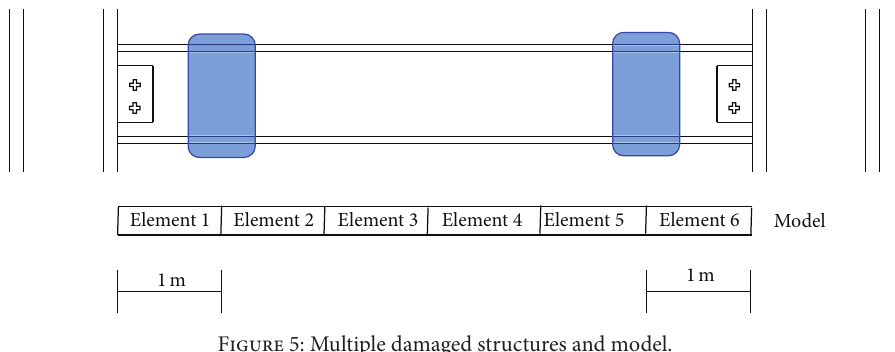
Figure 5: Multiple damaged structures and model.